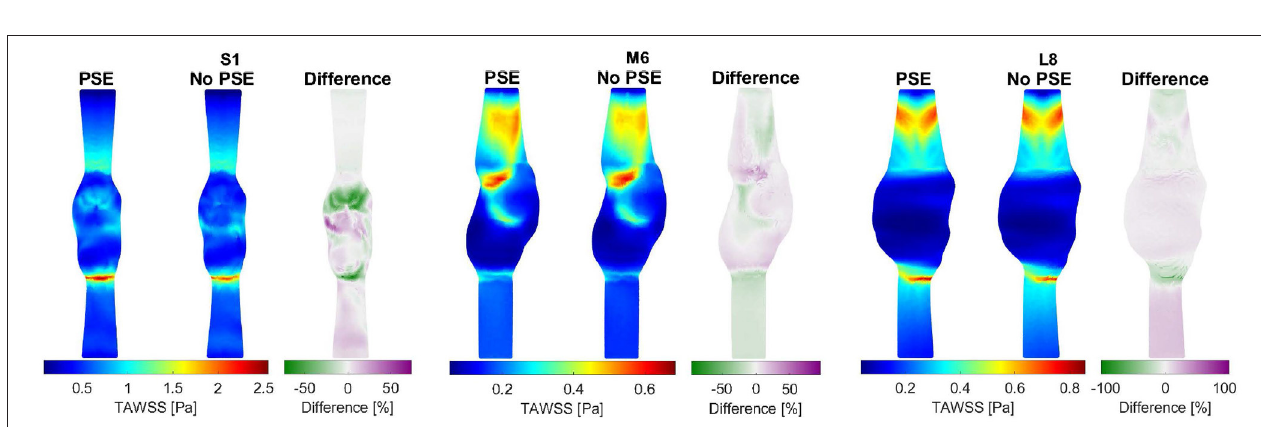
FIGURE 9 | Visualization of the time-averaged wall shear stress (TAWSS) resulting from the FSI simulations with and without PSE, and the difference in TAWSS for patients S1, M6, and L8.